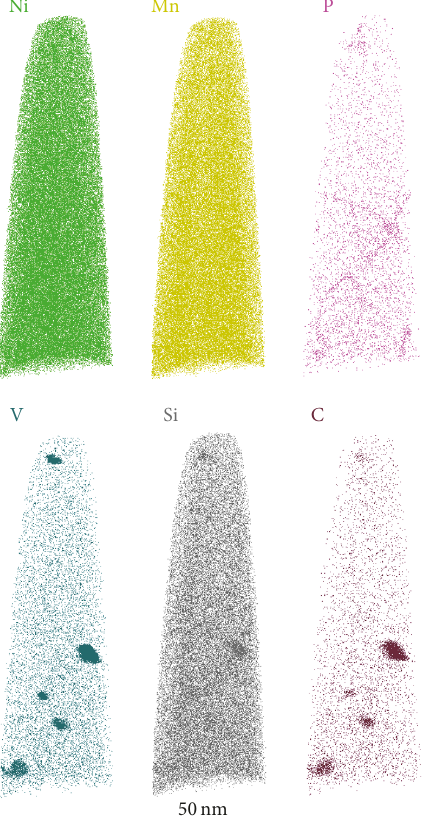
Figure 11: 3D mapping of Ni, Mn, P, V, Si, and C obtained by APT in the steel irradiated at 𝑇 = 400 ∘ C.